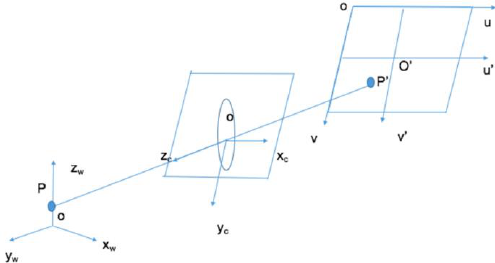
Figure 5. Four coordinate relationships, from left to right: the world coordinate system, the camera coordinate system, the image-plane coordinate system, and the pixel coordinate system.